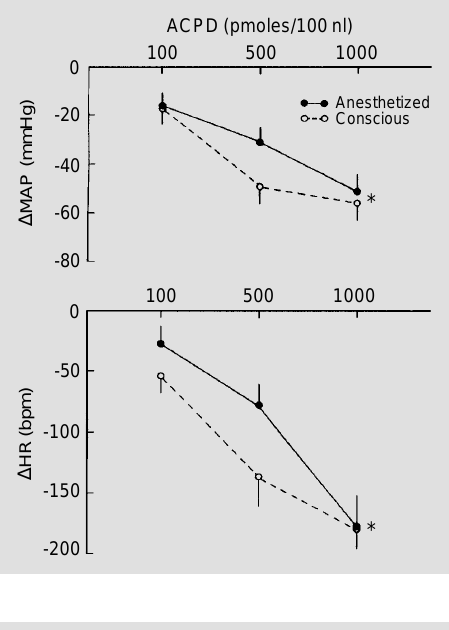
Figure 4 - Changes in mean arte- rial pressure ( D MAP, upper left panel) and heart rate ( D HR, bot- tom left panel) in response to microinjections of saline (100 nl) and L-glutamate (L-GLU; 1 nmol/ 100 nl) into the NTS of con- scious rats (N = 8) and changes in MAP (upper right panel) and HR (bottom right panel) in re- sponse to microinjections of sa- line (100 nl) and L-GLU (1 nmol/ 100 nl) into the NTS of the same group of rats under chloralose anesthesia. *P<0.05 compared to saline microinjection (paired t- test). + P<0.05 compared to